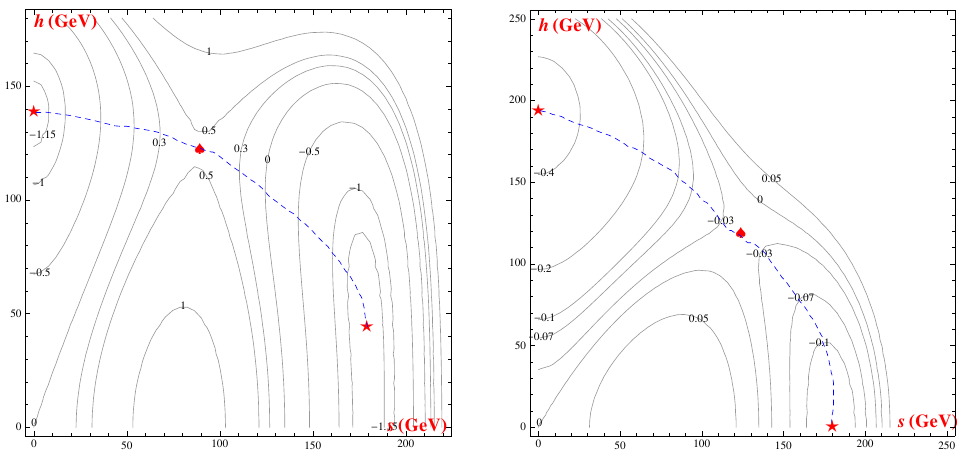
Figure 1 . Examples for two vacua separated by a tree level barrier: (cid:10) h with a metastable (cid:10) sh (left panel) or metastable (cid:10) s (right panel). The contours are equipotential curves, rescaled by large numbers which are of no importance here. The red stars and hearts stand for minima and saddle points, respectively. The dashed lines schematically show the tunneling paths from (cid:10)